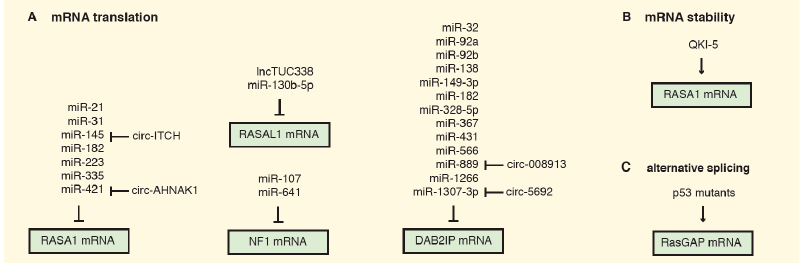
Figure 2. Schematic overview of current evidence for post-transcriptional regulation of RasGAPs. ( A ) MicroRNA-dependent regulation. Both miRNAs and long non-coding RNAs (lncRNA and circ-RNA) are involved in modulating RasGAP mRNA translation both directly and indirectly. ( B ) Control of mRNA stability. Stability of RASA1 mRNA can be fostered by direct binding with the RNA-binding protein Quaking-5 (QKI-5); loss of QKI-5 can reduce RASA1 expression in cancer. ( C ) Control of alternative splicing. Expression of missense p53 mutant proteins enhances the inclusion of cytosine-rich exons in the mRNA of RasGAPs; the encoded proteins show defects in membrane association and reduced Ras inhibitory function.